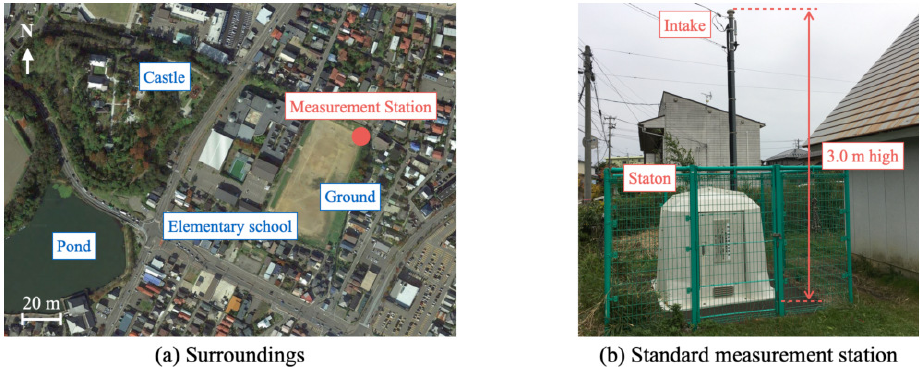
Figure 12. Honjo monitoring station for AEROS.